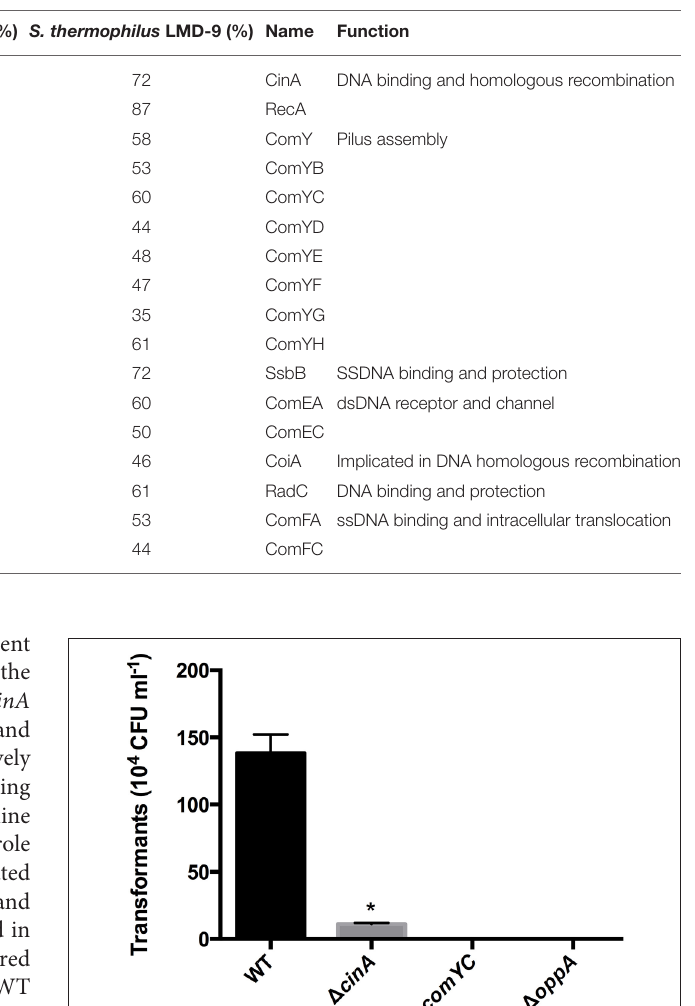
TABLE 2 | Transformasome genes under ComX regulation with their homologs in S. mutans, S. pneumonia, and S. thermophilus and their (putative) function.